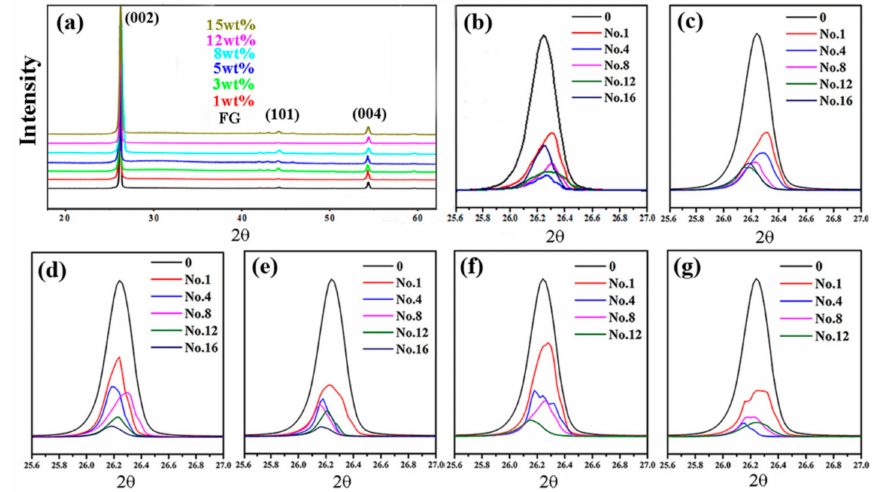
Figure 2. X-ray di ff raction (XRD) pattern of products ( a ) with di ff erent graphite contents and 16 exfoliations; XRD patterns of products exfoliated at di ff erent times with di ff erent graphite contents: